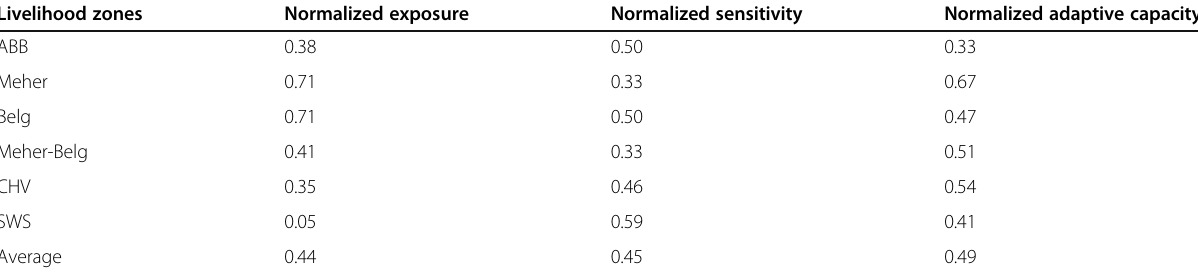
Table 7 Normalized indices of exposure, sensitivity, and adaptive capacity across the livelihood zones Livelihood zones